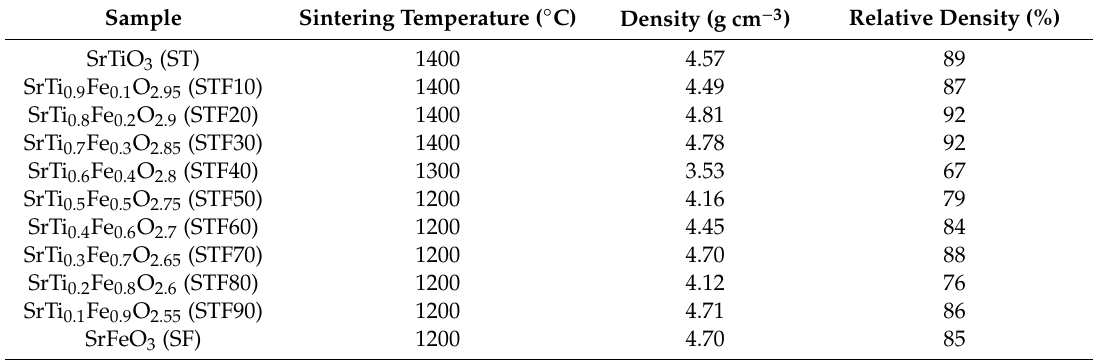
Table 1. The SrTi 1 − x Fe x O 3 − x / 2 − δ samples’ compositions, sintering temperature, densities, and